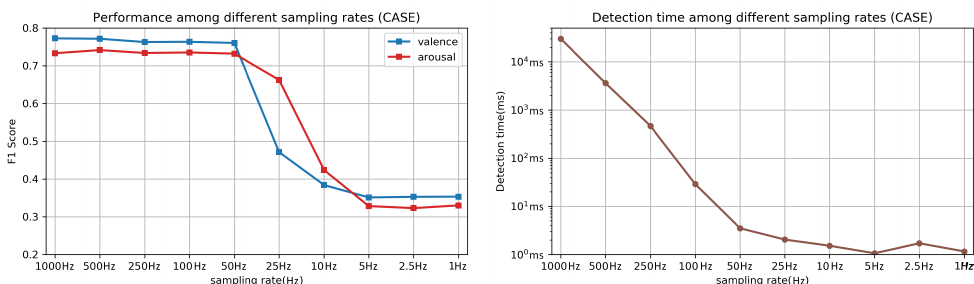
Figure 8. Comparison of the performance among different sampling rates: W-F1 of binary classifica- tion (LOSOCV, left ) and detection time ( right